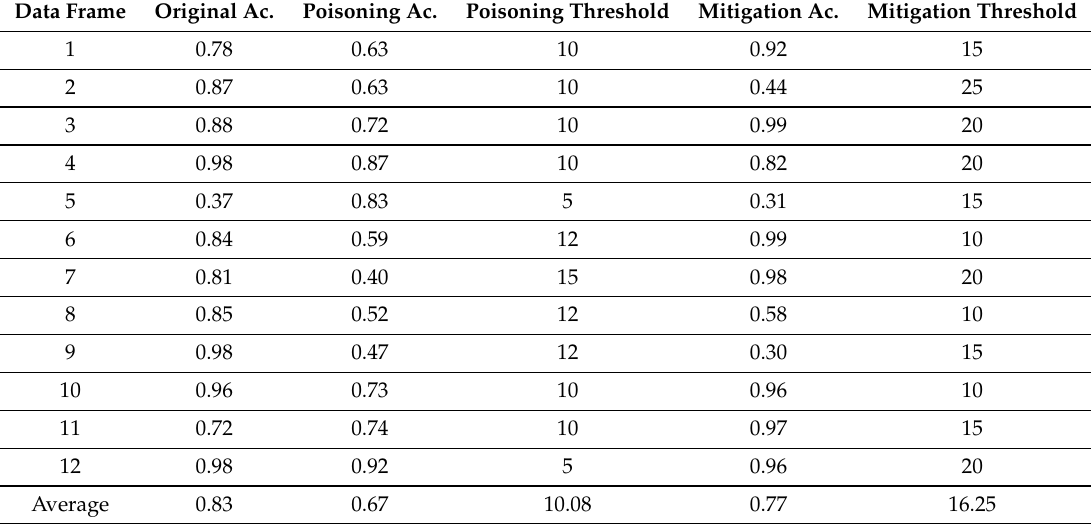
Table 6. Dynamic Adversarial Attacks and Mitigation New Entries.